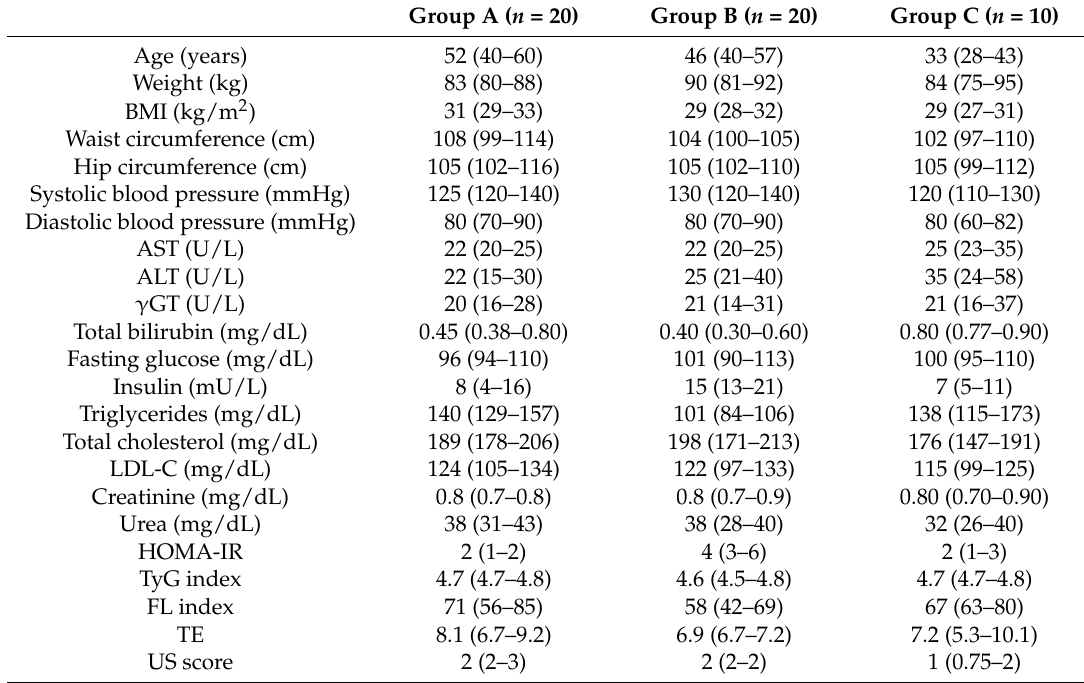
Table 1. Characteristics of the study population stratified into the three groups, at